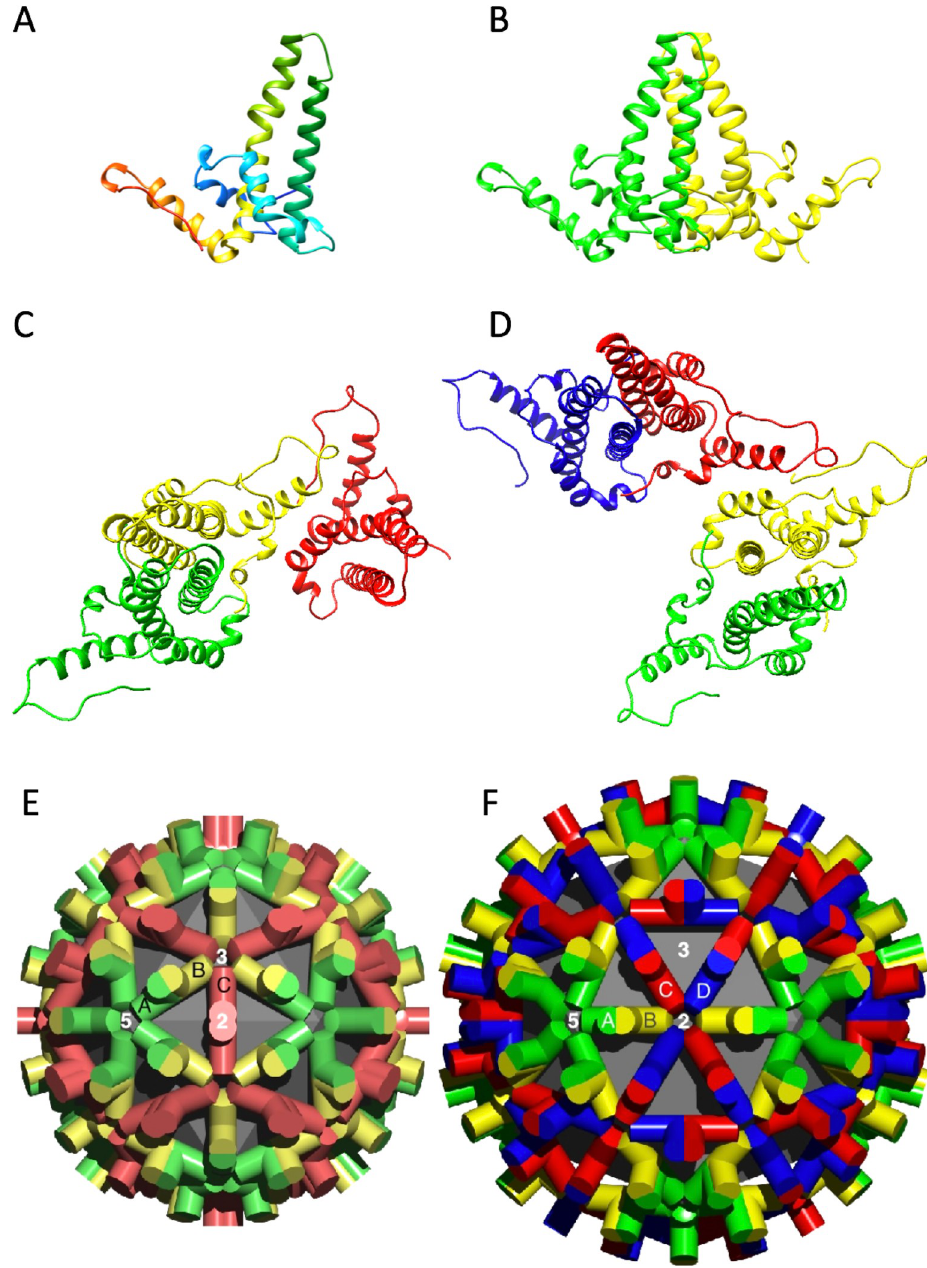
Fig 2. Conformation of core protein and its arrangement in capsids. (A) Ribbon diagram of a single chain colored from N-terminus (blue) to C-terminus (red). Such chains do not exist in isolation. (B) An AB dimer with the A and B chains colored green and yellow, respectively. (C) The A, B, and C chains of T = 3 capsids colored green, yellow, and red, respectively. (D) The A, B, C, and D chains of T = 4 capsids colored green, yellow, red, and blue, respectively. (E, F) Lattices of the T = 3 and T = 4 capsids with the subunits labeled and colored according to the same convention. The chains in (C, D) are shown approximately as they are arranged in the corresponding lattices (E, F). The different shades in the lattices indicate